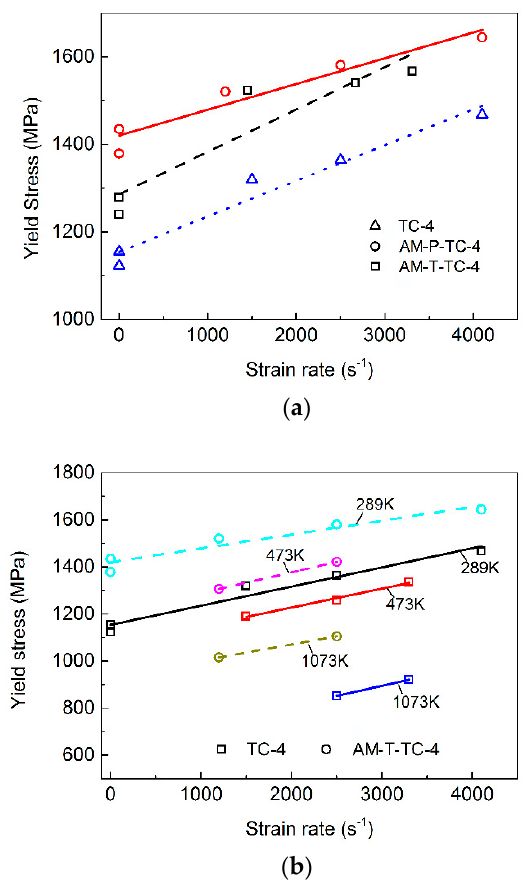
Figure 9. Effect of strain rate on the yield strength of materials: ( a ) Effect of strain rate on the yield strengths of TC-4, AM-P-TC-4, and AM-T-TC-4 at room temperature; ( b ) effect of strain rate on the yield strengths of TC-4 and AM-P-TC-4 at different temperatures.